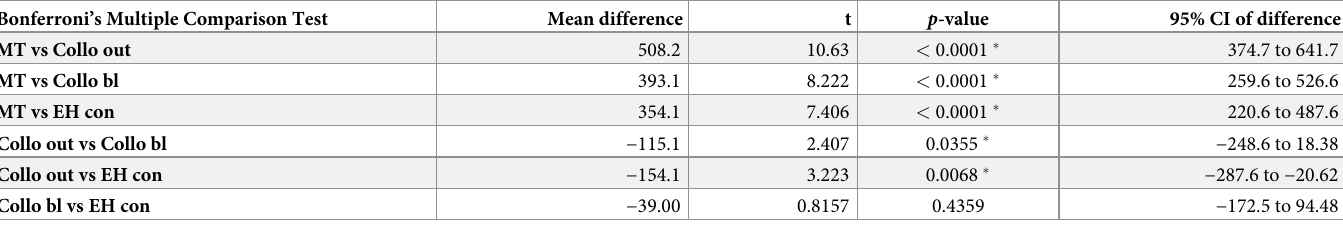
Table 1. Bonferroni’s multiple comparison test comparing the maximum resistance to plastic deformation between the groups. Bonferroni’s Multiple Comparison